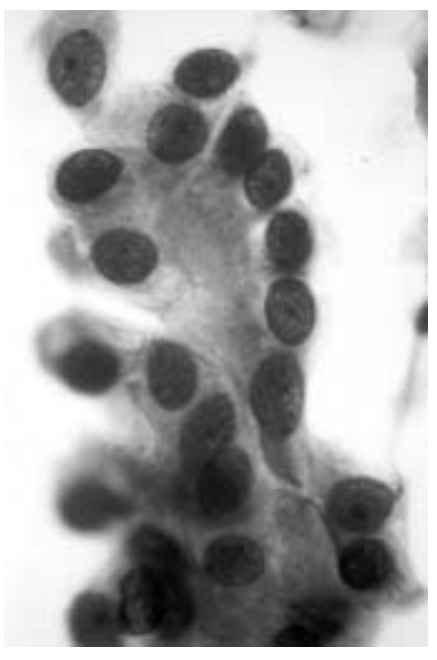
Fig. 1. Brushing smear from benign and uneffected squamous cells of conjunctiva. Magnification 63 × .